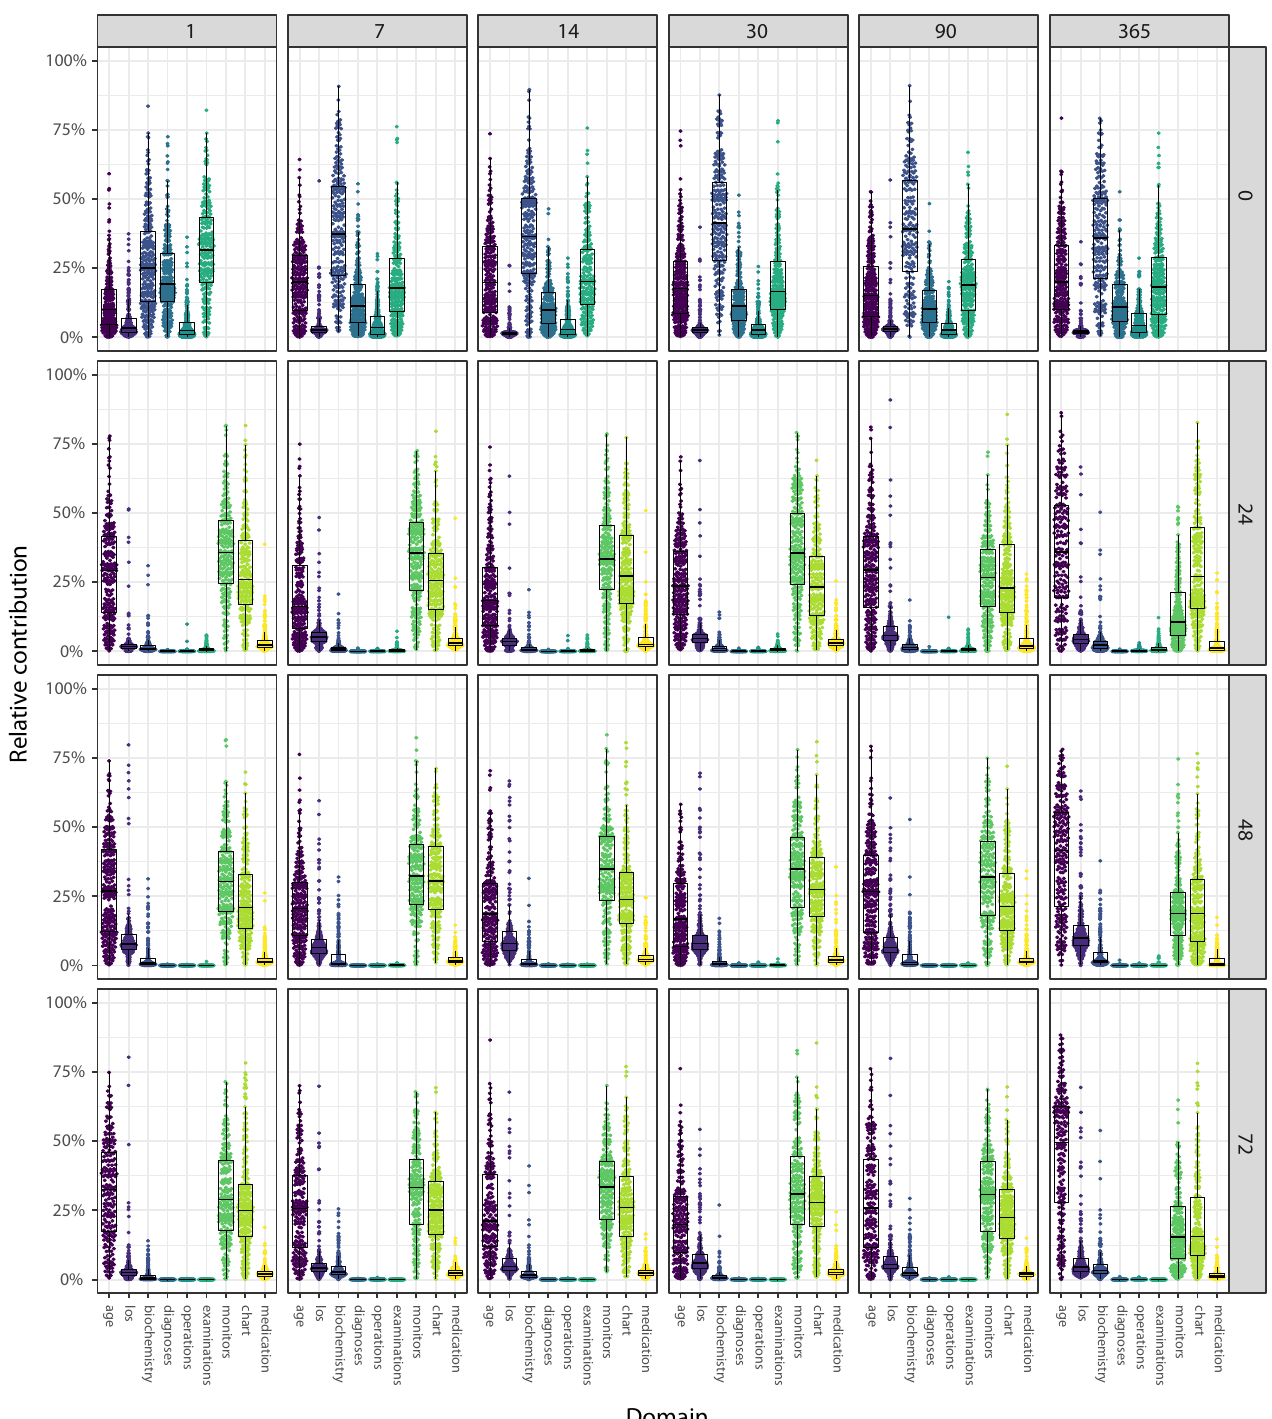
Fig. 4 The impact of input domains on survival predictions. Each dot represents the relative contribution from a data domain to a given prediction for one patient. LOS = Hospital length of stay before ICU admission. Each column and row correspond to a speci fi c prediction window (1, 7, 14, 30, 90, and 365 days) and baseline (0, 24, 48, and 72 h), respectively. In the fi gure the centre lines denote medians, bounds of boxes represent 25th (Q1) and 75th percentiles (Q3). Whiskers denote nonoutlier data range de fi ned by Q1 − 1.5 interquartile and Q3 + 1.5 interquartile